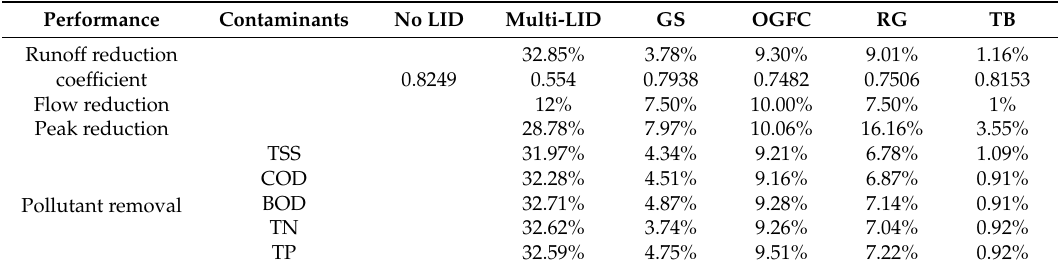
Table 4. Pollutants removal change during the 50-year recurrence by SWMM 5.0, Scenario 01.